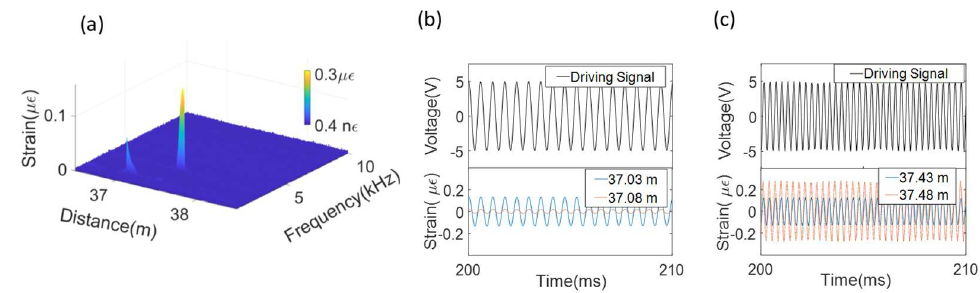
Figure 6. ( a ) Strain as functions of frequency and distance. ( b ) Driving signal (upper) to PCC 1 and the reconstructed temporal signals centered at 37.03 m and 37.08 m (lower). ( c ) Driving signal (upper) to PCC 2 and the reconstructed temporal signals centered at 37.43 m and 37.48 m (lower).